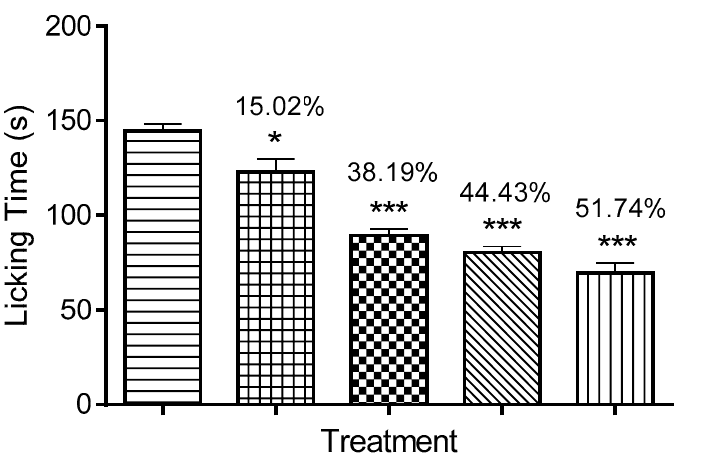
Figure 4. Effect of MEDL on capsaicin-induced nociception in mice. Each column represents the mean ± SEM of six mice. Statistical analyses were performed using 1-way ANOVA followed by Tukey’s multiple comparisons test. * p ≤ 0.05, ** p ≤ 0.01 and *** p ≤ 0.001 compared to vehicle control group. Values on top of each column denote inhibition.